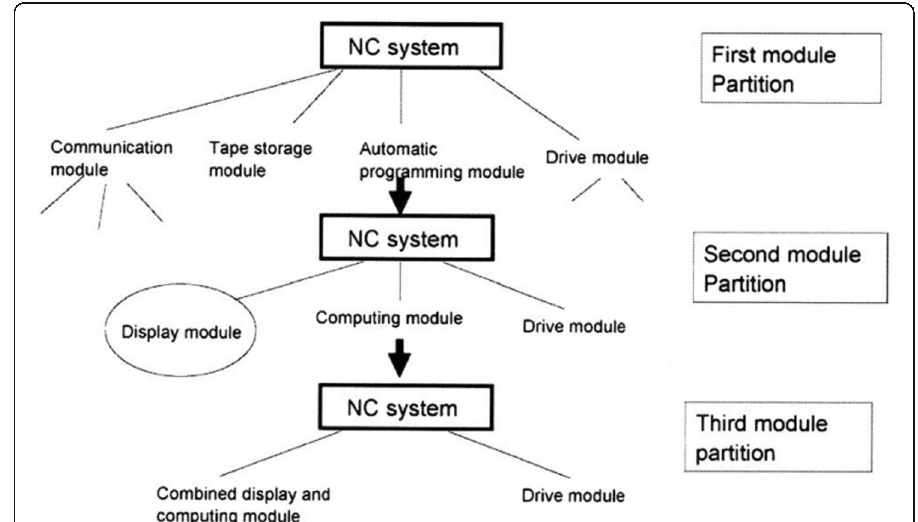
Fig. 6 Changes in module partition of NC machine tool. Source: Shibata